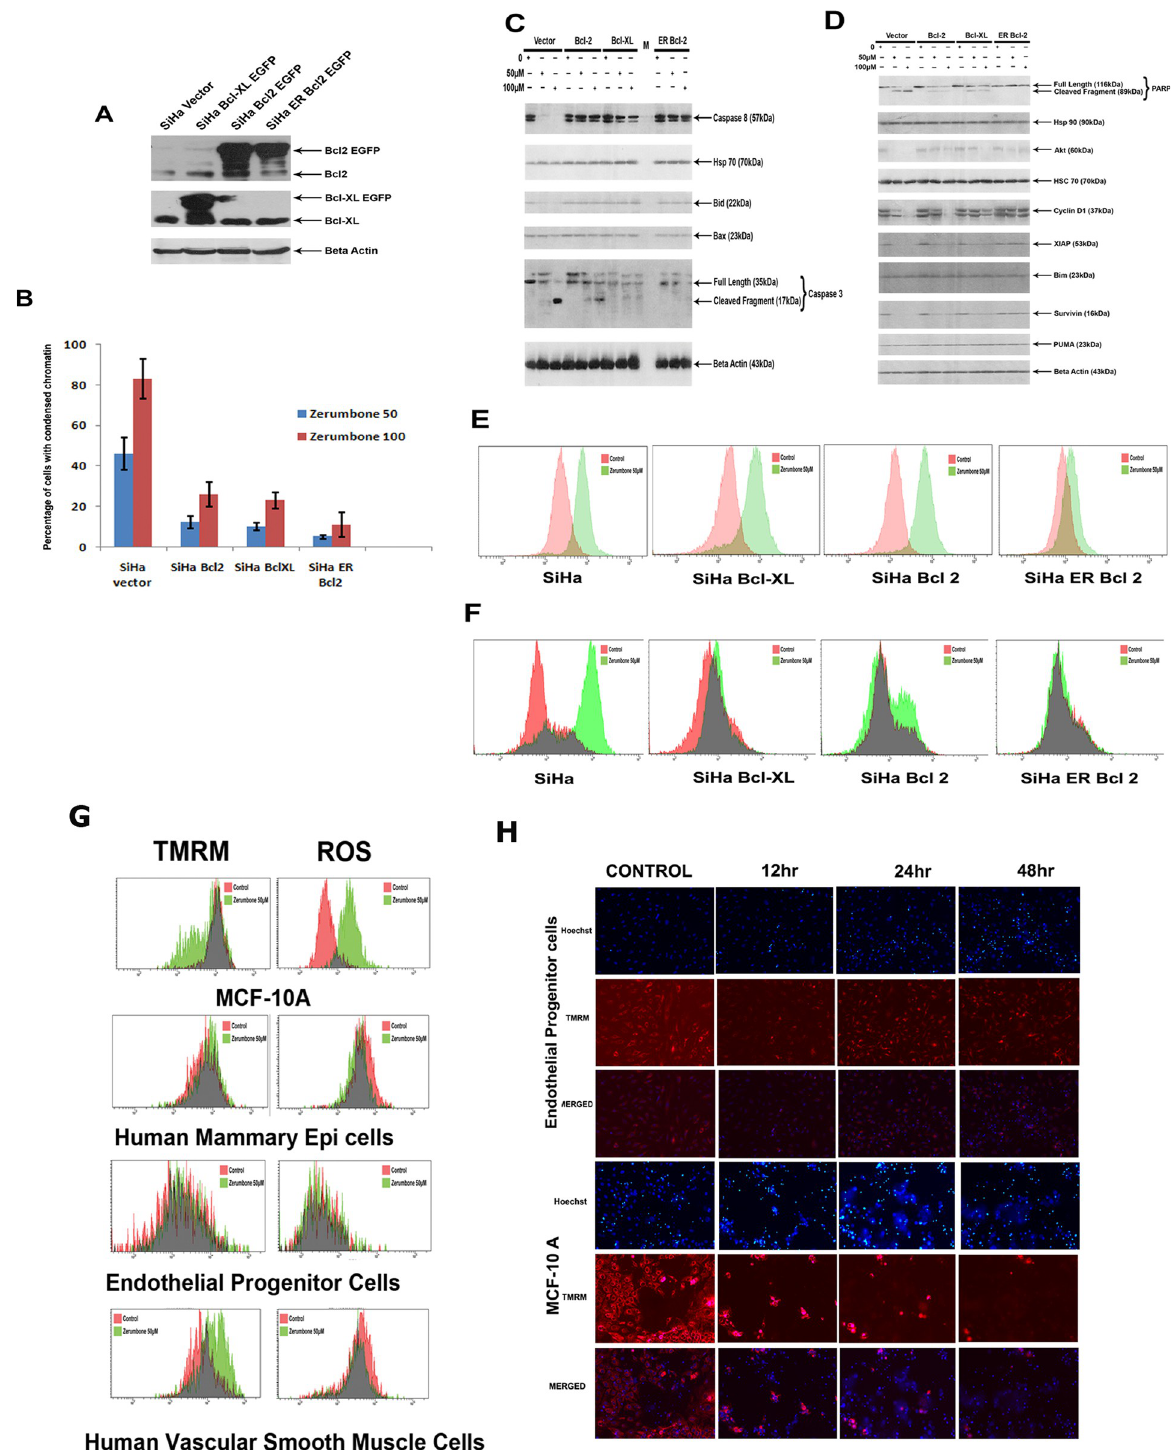
Fig 6. ER targeted Bcl 2 prevents cell death induced by zerumbone than wild type Bcl 2 or Bcl-XL. A. SiHa cells were transfected with vector alone or Bcl-XL–EGFP, Bcl2- EGFP and ER-Bcl2. The whole cell extract prepared from the cell was probed for Bcl2 and Bcl-XL. Beta actin is served as the loading control. (B). The above panel cell lines were treated with zerumbone 50 μ M and 100 μ M for 24 h. Then the cells were stained with Hoechst to quantify chromatin condensation. The results shown is average ± SD (n = 4)( �� p � 001). (C). The whole cell extract prepared from vector alone or BclXL–EGFP, Bcl2 EGFP and ERBcl2, untreated, or treated with zerumbone 50 μ M and 100 μ M for 24 h were probed with